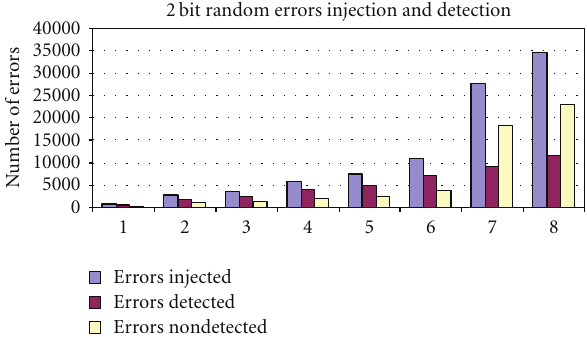
Figure 25: Simulation Curves for Group I.